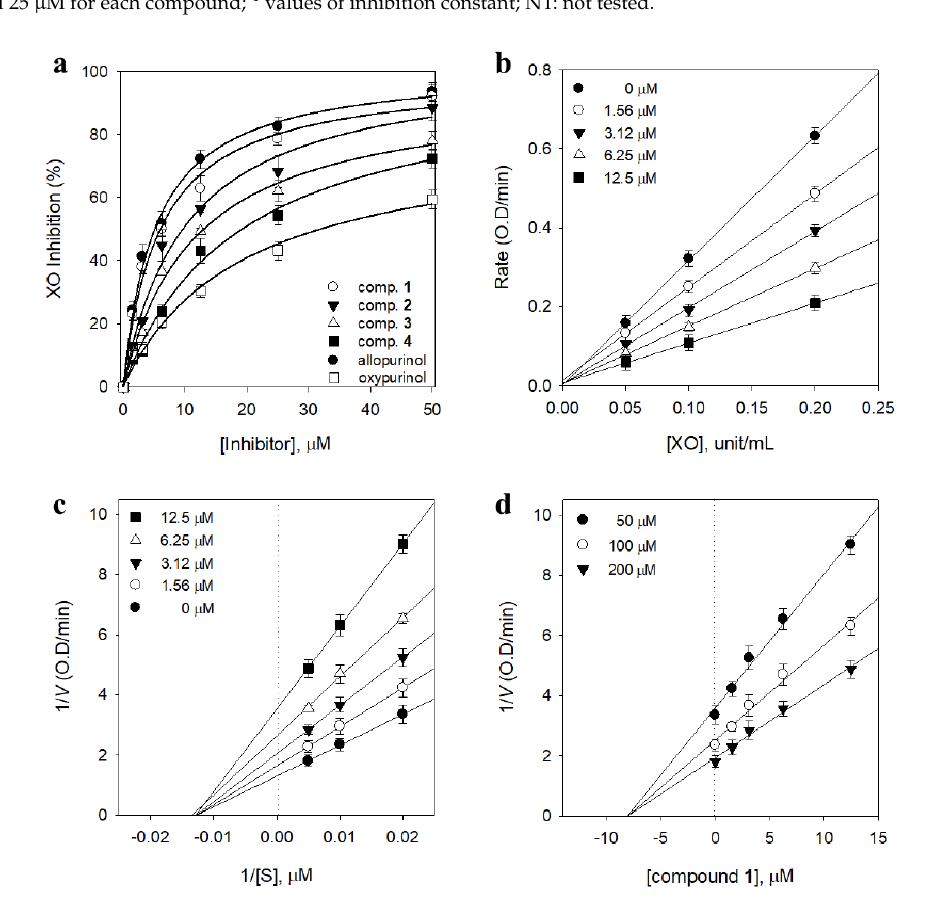
All extracts and compounds were examined in a set of experiments repeated three times. 1 Extrac- tion yields are given as mg/g dry weight; 2 IC 50 values of compounds represent the concentration that caused 50% enzyme activity loss; 3 sample concentration was 125 ppm (µg/mL) for the extract and 25 µM for each compound; 4 values of inhibition constant; NT: not tested.